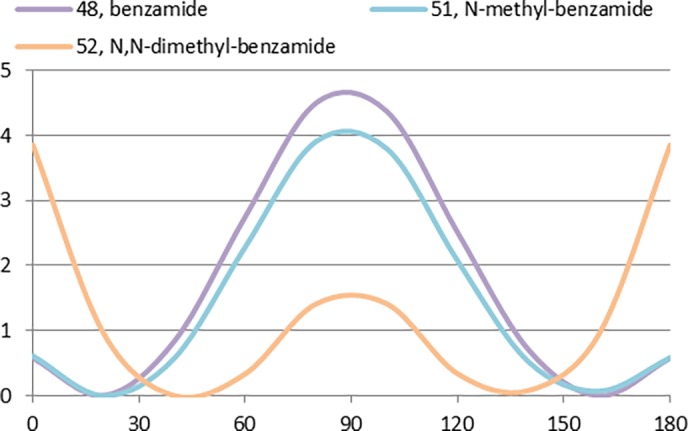
Effect of methylated amides in the CEP profile of benzamides 48, 51 and 52.